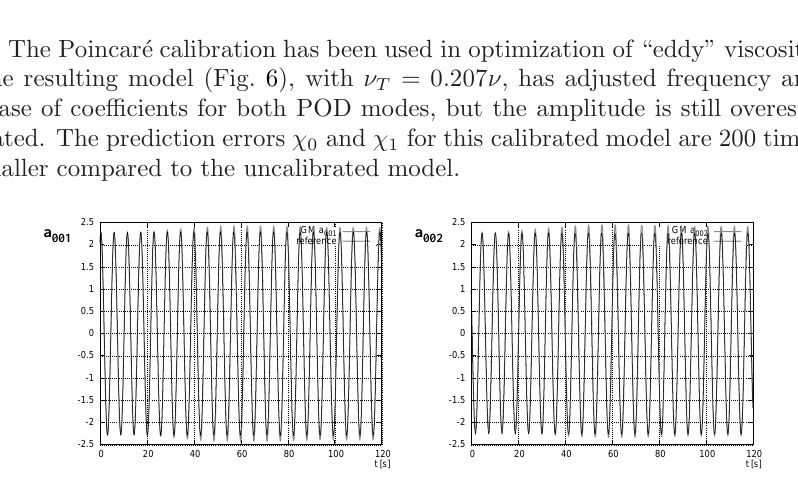
Figure 6. Three-equation Galerkin model with “eddy” viscosity calibration.